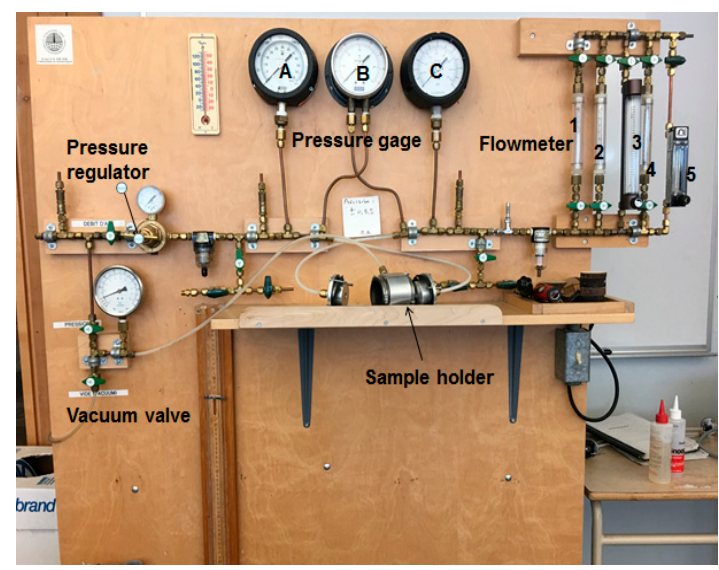
Figure 3. Apparatus used for gas permeability measurements.